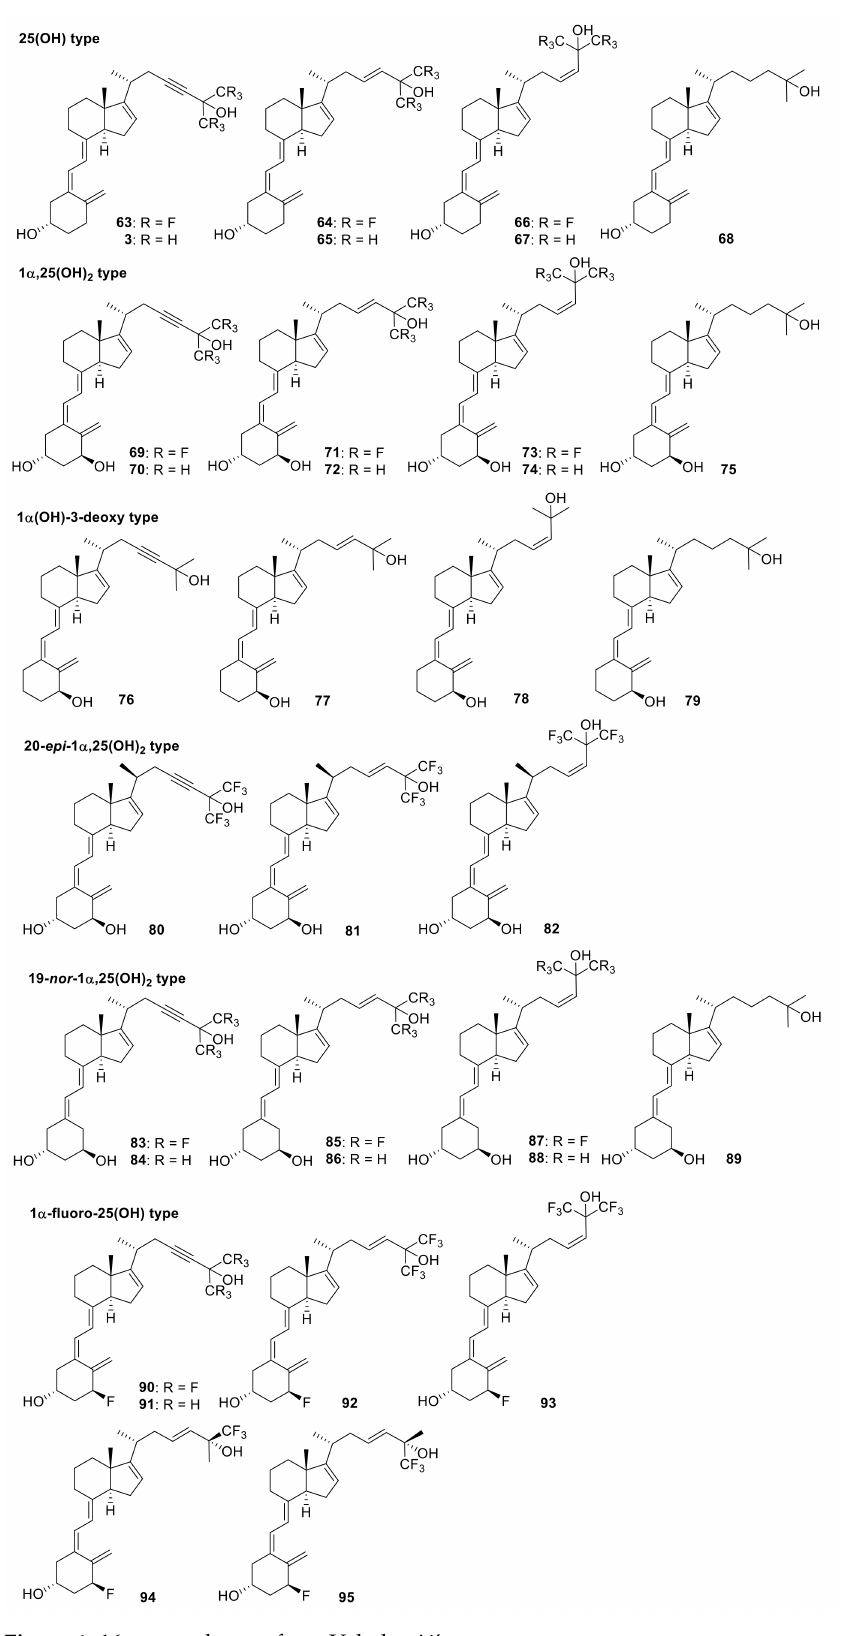
Figure 1. 16-ene analogues from Uskokovi´c’s